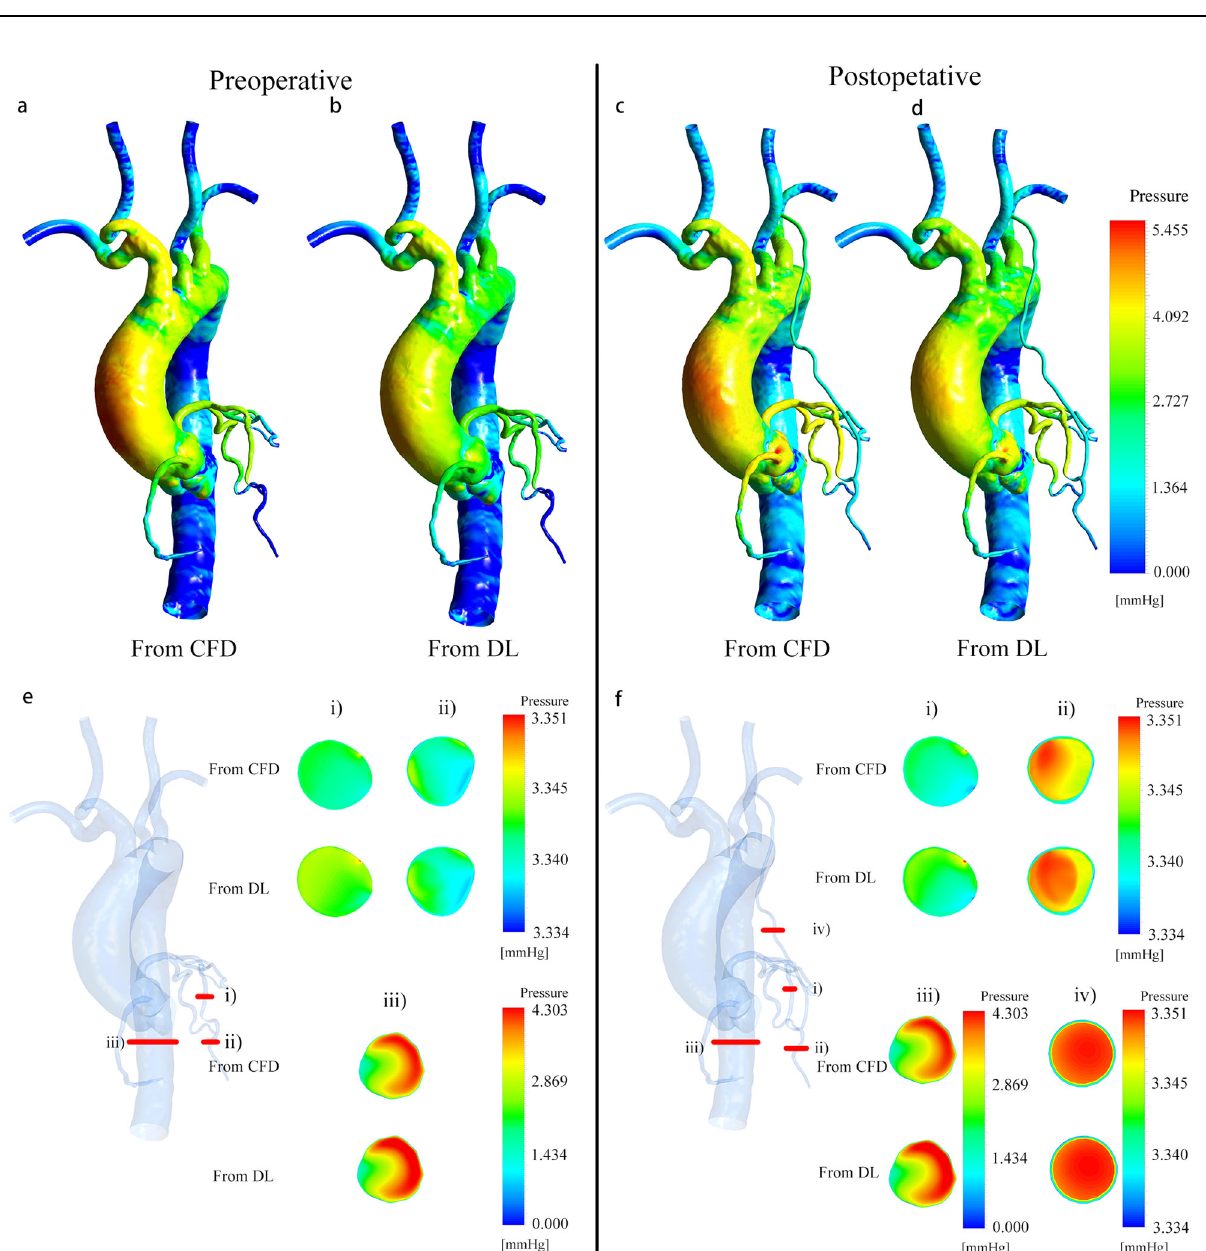
Fig. 2 Comparison of pressure fi eld from CFD and deep learning (DL), using a sample with a stenosis rate of 85%. Because the CFD outlet boundary was set as zero pressure condition, the pressure value in this fi gure was actually the pressure difference relative to the coronary outlet. a – d Are pressure distribution cloud maps of the entire cardiovascular before and after CABG obtained from CFD and DL. e , f Are cross-sectional views of the pressure distribution, respectively from (i): the proximal end of LAD before stenosis; (ii): the distal end of LAD after stenosis; (iii): descending aorta; iv): graft. The comparison results con fi rm the high consistency of the pressure fi eld obtained by the two methods. The results of coronary pressure prediction can help us calculate FFR to further evaluate the performance of our deep learning